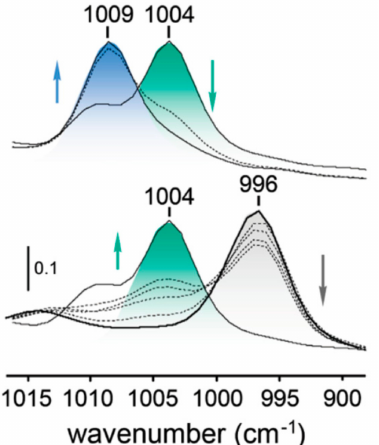
Figure 17. In situ infrared spectra of Co(BDP), during N 2 adsorption at 100 K. Phase transitions from the dry form (gray) to ip1 (green) and ip2 (blue). Reprinted